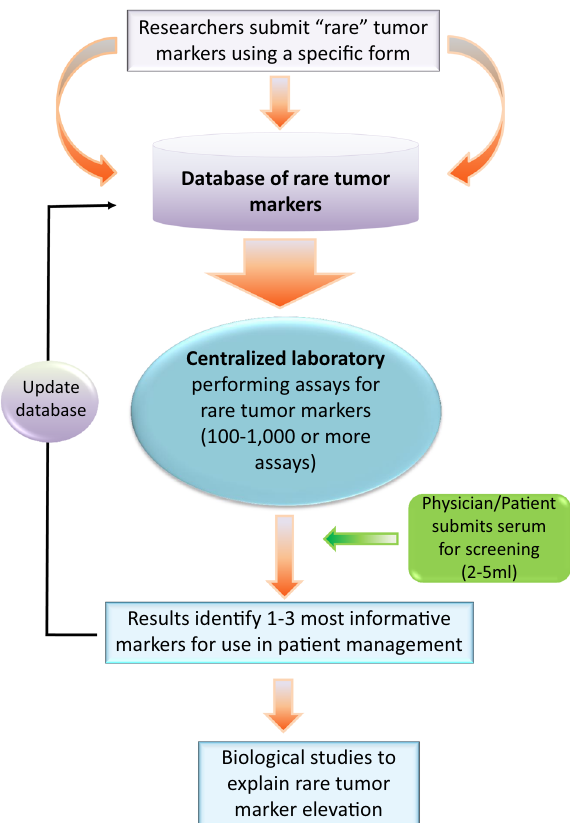
Fig. 1 Personalized tumor marker database and clinical use. See text for more